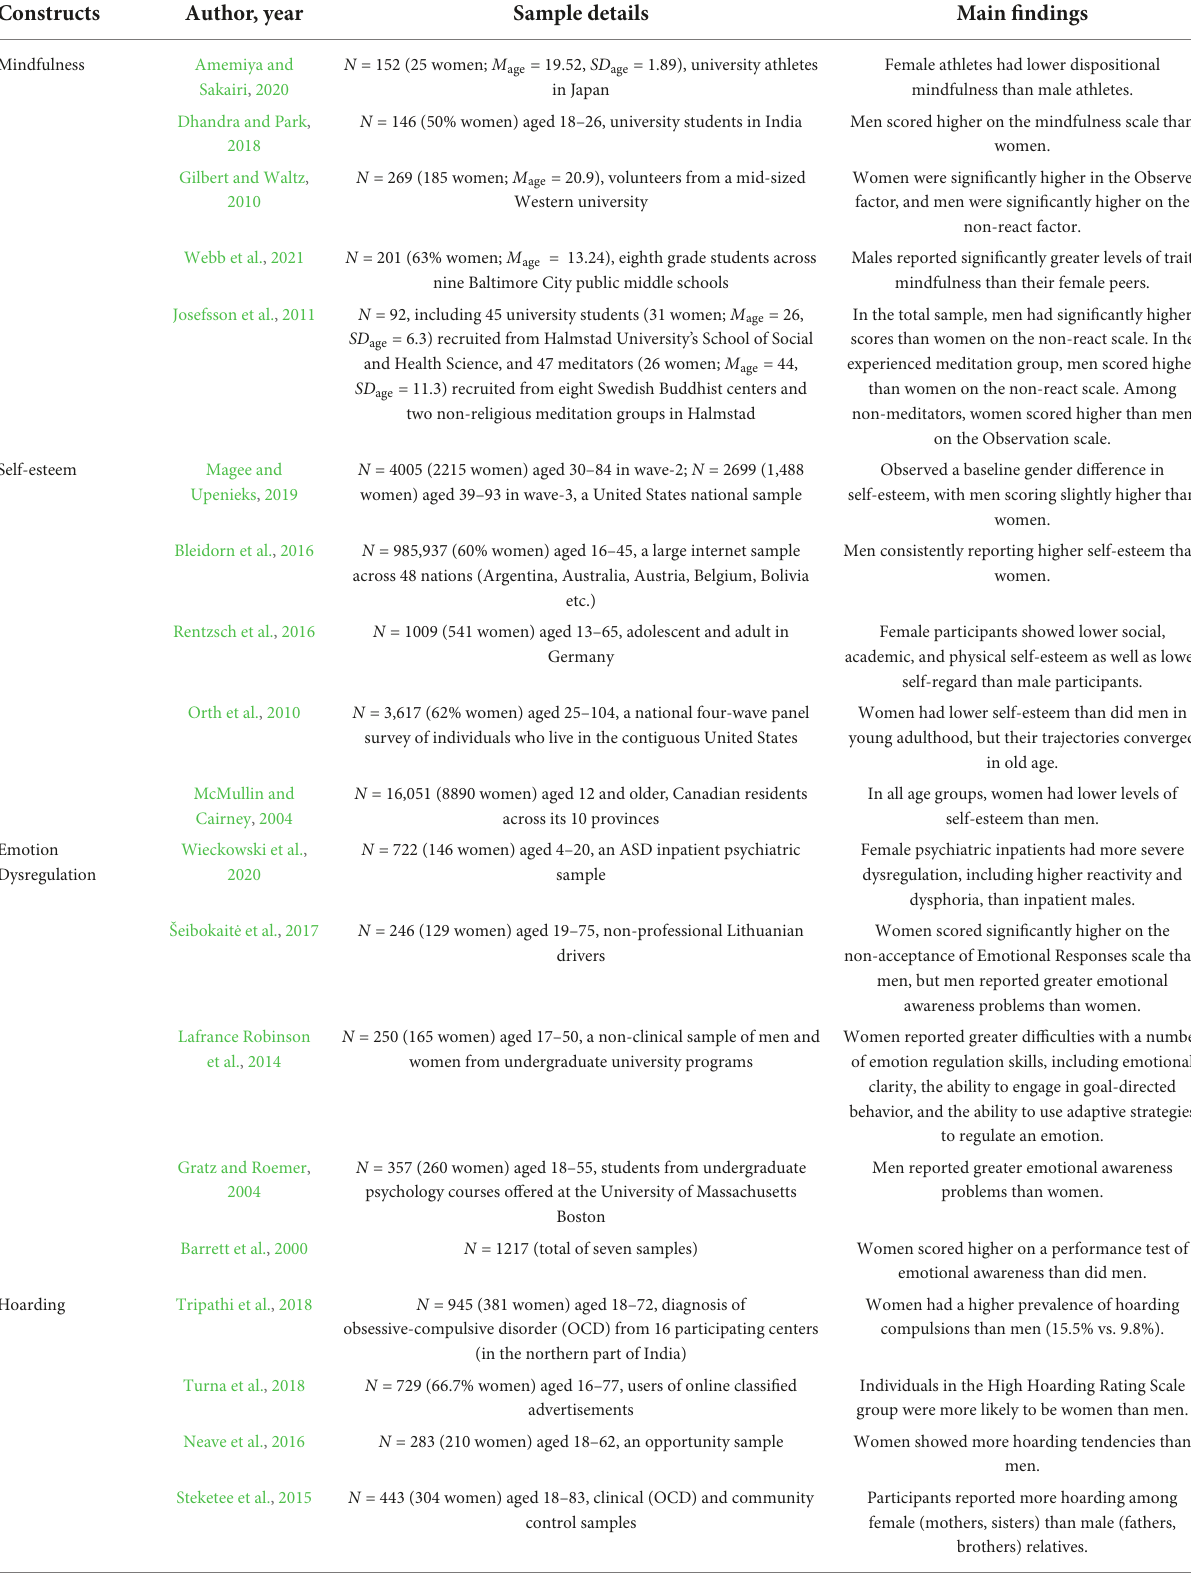
TABLE 1 Summary of studies reviewed in the gender differences for mindfulness, self-esteem, emotion dysregulation, and